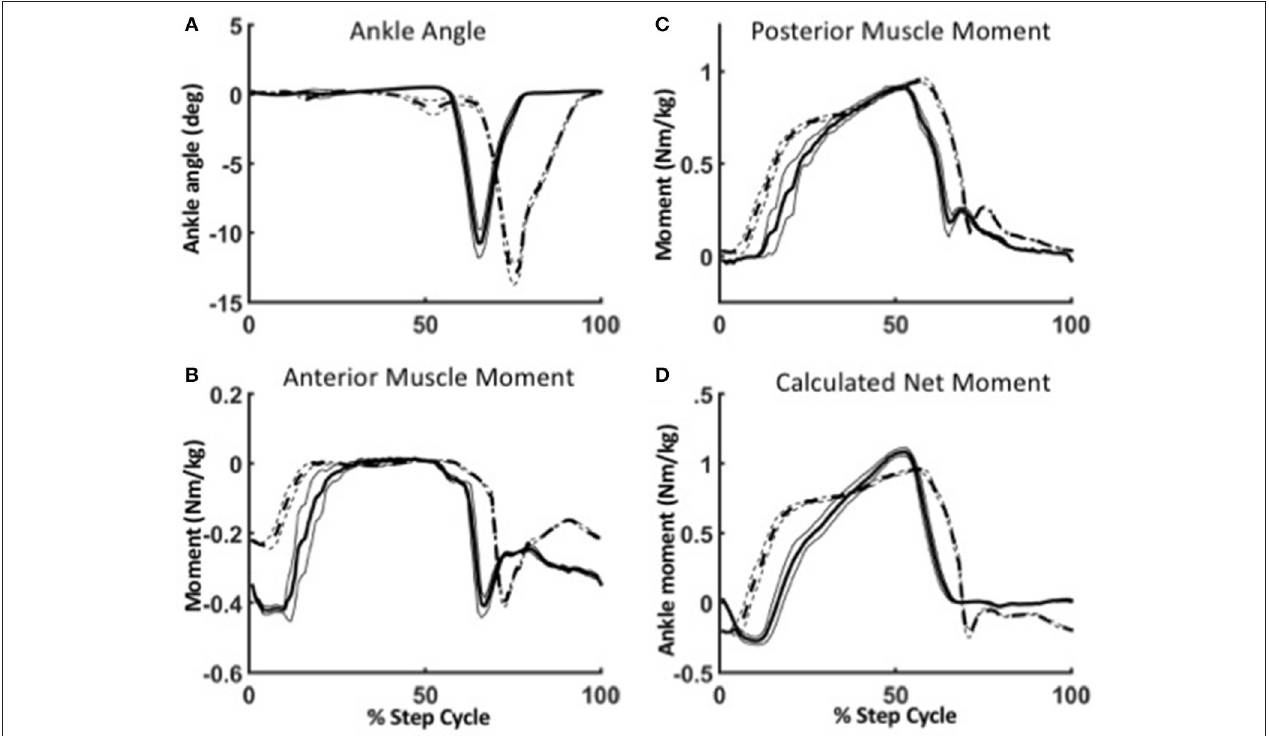
FIGURE 8 | Robustness of the WFH algorithm during level walking (solid lines) and stair ascent (dotted lines). (A) Between level walking and stair ascent, the only difference in parameters is the ankle angle. Ankle plantarflexion is larger and occurs later in the gait cycle during stair ascent than during level walking. The change in ankle angle results in different virtual muscle lengths and velocities, which in turn affect the ankle moments produced by the anterior (B) and posterior (C) muscle models. The net ankle moment (D) is the torque command sent to the motor. Lines represent mean ± 1